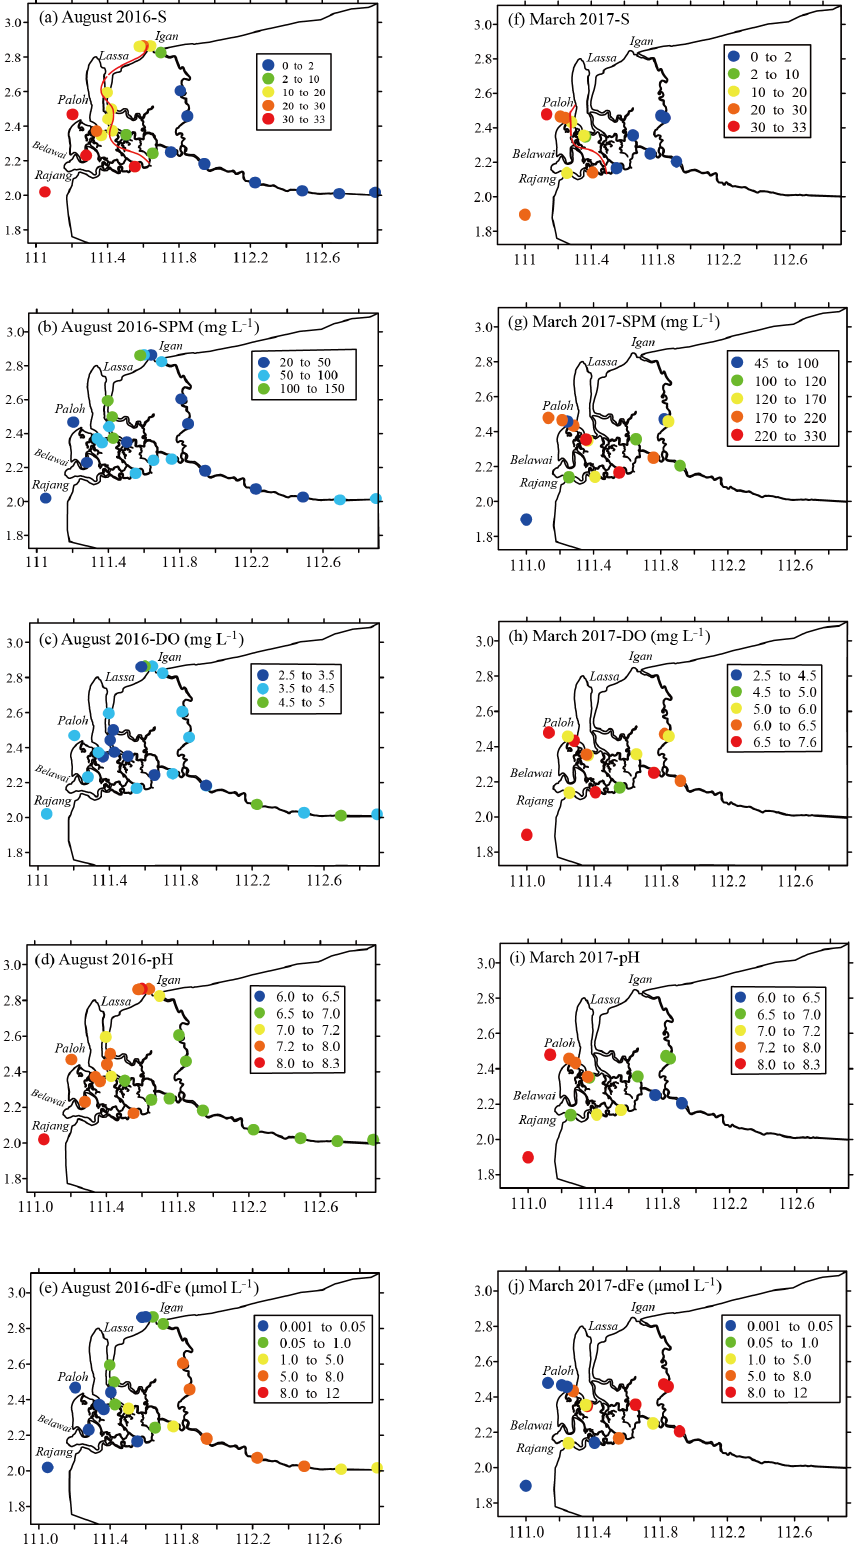
Figure 2. Spatial distributions of the salinity ( a and f ), suspended particulate matter (SPM; b and g ), dissolved oxygen (DO; c and h ), pH ( d and i ) and dissolved iron (dFe; e and i ) in the Rajang River in August 2016 and March 2017, respectively. The red solid line is the isosalinity line ( S = 15) linearly interpolated from S in this